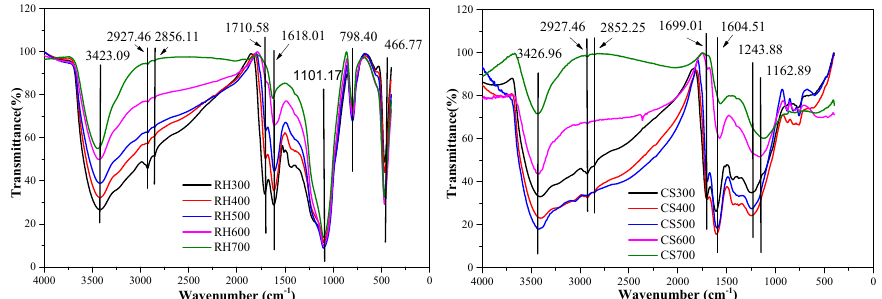
Figure 2. Fourier-transform infrared (FTIR) spectra of the biochar samples obtained at various pyrolysis temperatures. Notes: RH300, RH400, RE500, RH600, and RH700 indicate that rice husk were pyrolyzed at 300, 400, 500, 600 and 700 °C, respectively; CS300, CS400, CS500, CS600, and CS700 indicate that cotton straw were pyrolyzed at 300, 400, 500, 600 and 700 °C, respectively.